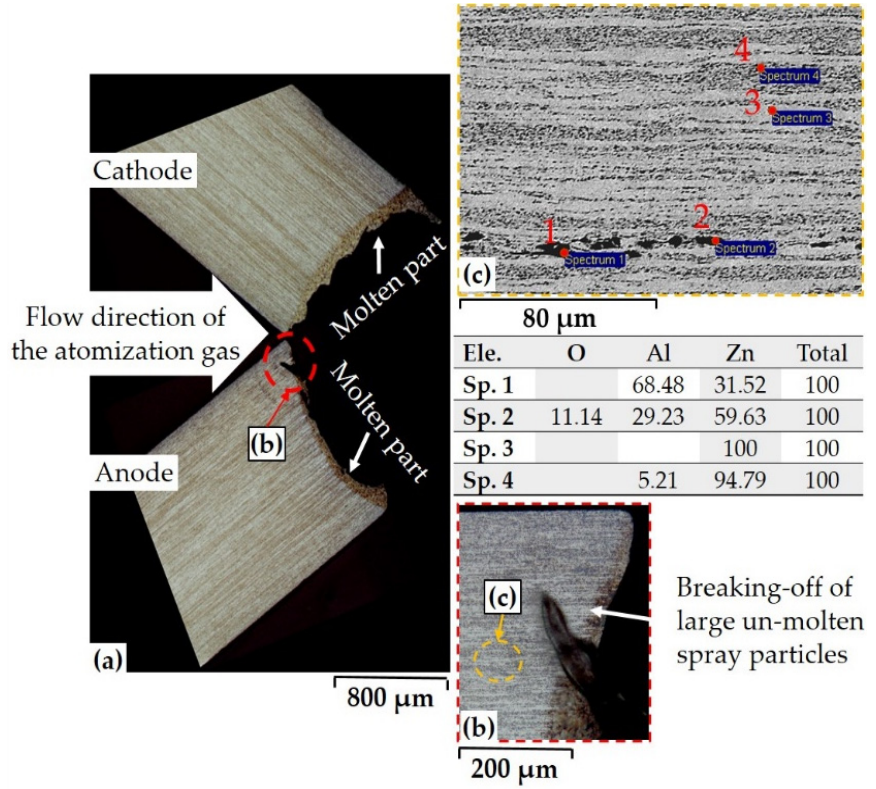
Figure 5. Melting behavior and microstructure of the feedstock ZnAl4 wires, ( a ) light microscopy image resemble the configuration of the intersecting wires in the TWAS process, ( b ) SEM image of possible detachment zone of large ruptures, and ( c ) point analyses of the sprayed wires.